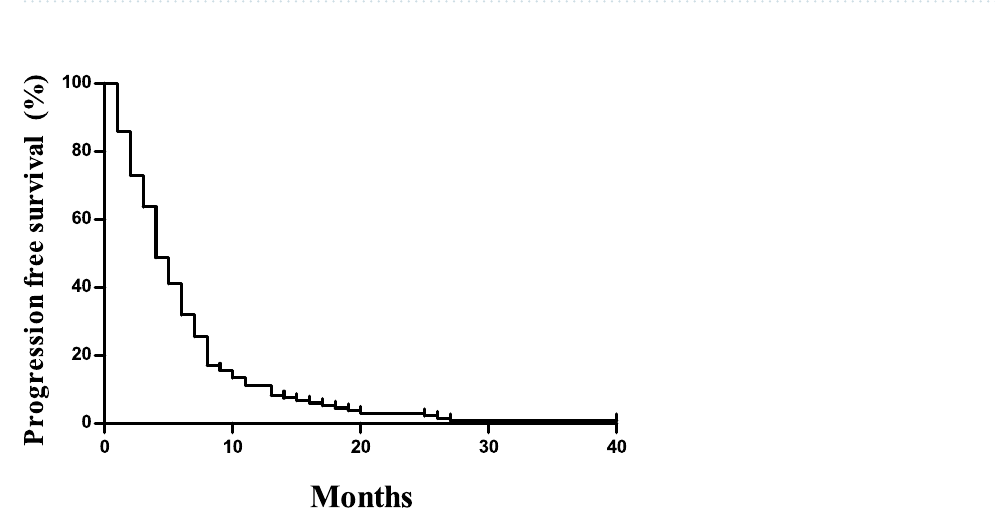
Table 2. Treatment exposure (safety population).